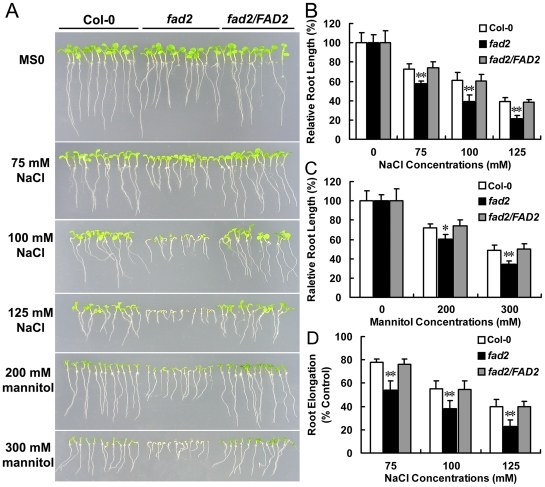
Stress response of Col-0, fad2 and fad2/FAD2.Col-0, wild-type Columbia; fad2, FAD2 mutant; fad2/FAD, transgenic fad2 line 1 complemented with the Col-0 FAD2 gene (fad2/FAD2-1). (A) Phenotypes on MS medium supplemented with different concentrations of NaCl or mannitol. Photos were taken 7 days after the initiation of the treatments. B and C, Root growth on MS medium supplemented with different concentrations of NaCl (B) or mannitol (C) from (A). The relative root lengths were measured on day 7 after stratification (n = 60 for each condition). (D) Root elongations on MS medium supplemented with different concentrations of NaCl. Four-day-old seedlings were transferred to MS medium supplemented with 0, 75, 100 or 125 mM NaCl. Results are presented as means and standard errors from three independent experiments. * and ** indicate significant differences in comparison to Col-0 at P<0.05 and P<0.01, respectively (Student's t-test).